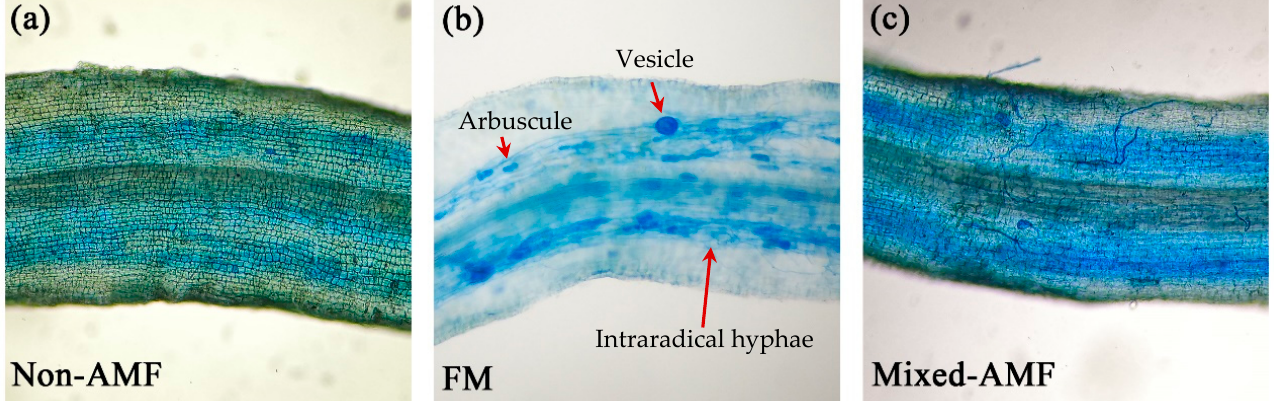
Figure 1. Mycorrhizal colonization of Ponkan mandarin roots grafted on trifoliate orange under field inoculations with non-AMF ( a ), F. mosseae ( b ), and mixed-AMF ( c ), respectively. The fine roots of the current year were collected from 5 − 15 cm soil depth and stained with trypan blue in lactoglycerol. These figures of mycorrhizal colonization were taken and used to calculate the degree of root mycorrhizal fungal colonization.